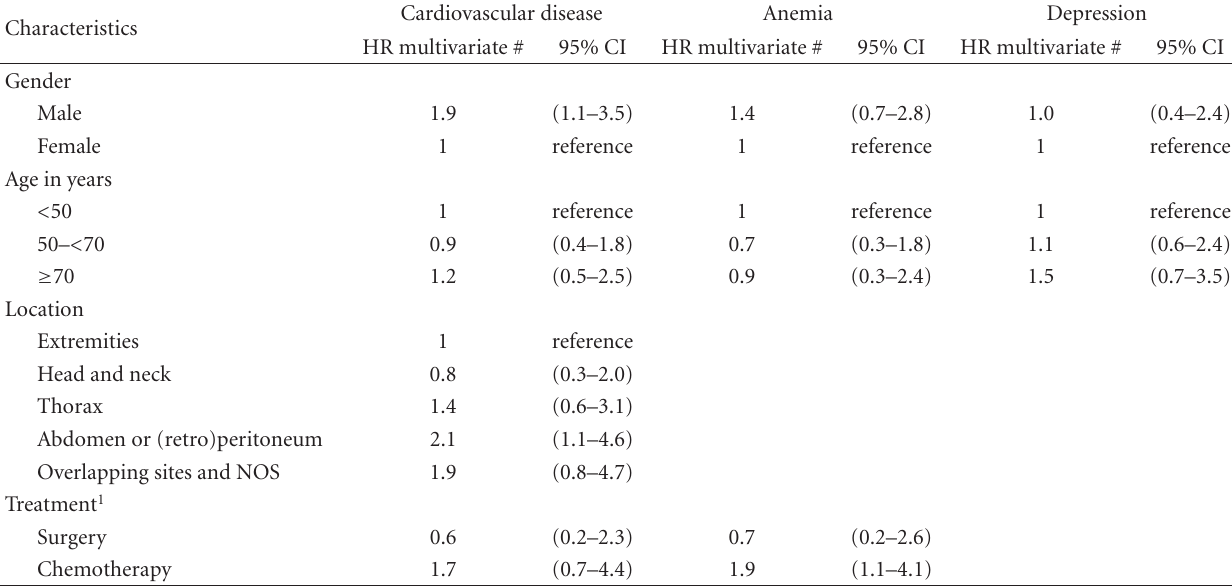
Table 4: Risk factors for developing cardiovascular disease, anemia, and depression after soft tissue sarcoma